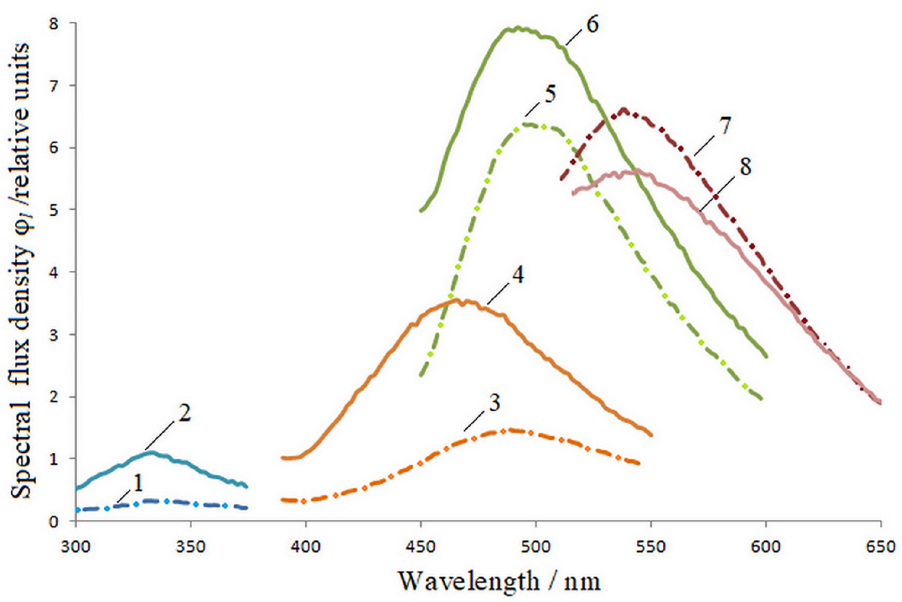
Fig 2. Luminescence spectra of barley seeds when excited by radiation. λ e = 232 nm: 1 –uninfected, 2 –infected; λ e = 362 nm: 3– uninfected, 4 –infected; λ e = 424 nm: 5 –uninfected, 6 –infected; λ e = 485nm: 7 –uninfected, 8 –infected.